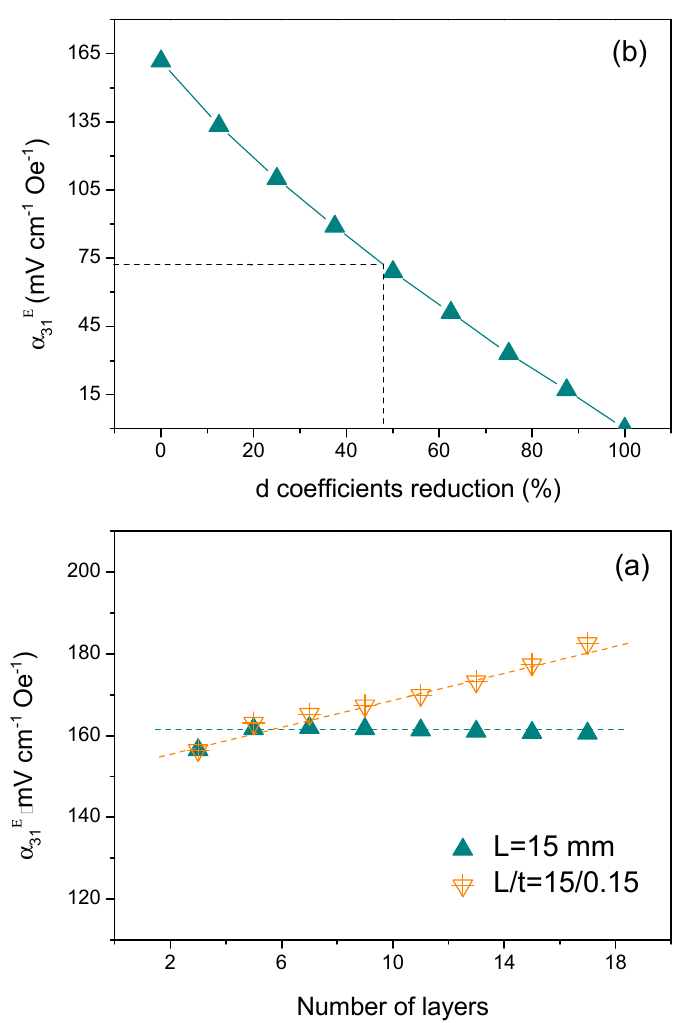
Figure 6. Magnetoelectric coefficient α 31 E resulting from simulation of 15 mm long, ( a ) multilayer structures with a layer thickness of 50 μ m, starting from a Bi 0.36 Pb 0.64 Sc 0.36 Ti 0.64 O 3 /NiFe 2 O 4 /Bi 0.36 Pb 0.64 Sc 0.36 Ti 0.64 O 3 three-layer structure to which bilayers are successively added (results corresponding to the simultaneous increase of length to maintain aspect ratio constant are also given); and ( b ) nine-layer structures of decreasing piezoelectric coefficients as a result of poor poling. The experimental value for an analogous composite disc is included in (b).